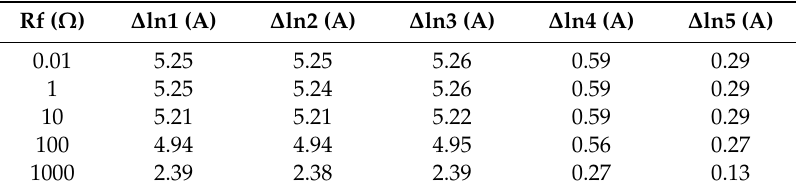
Figure 15. Rural compensated network. Table 3. Negative sequence currents in rural compensated network.